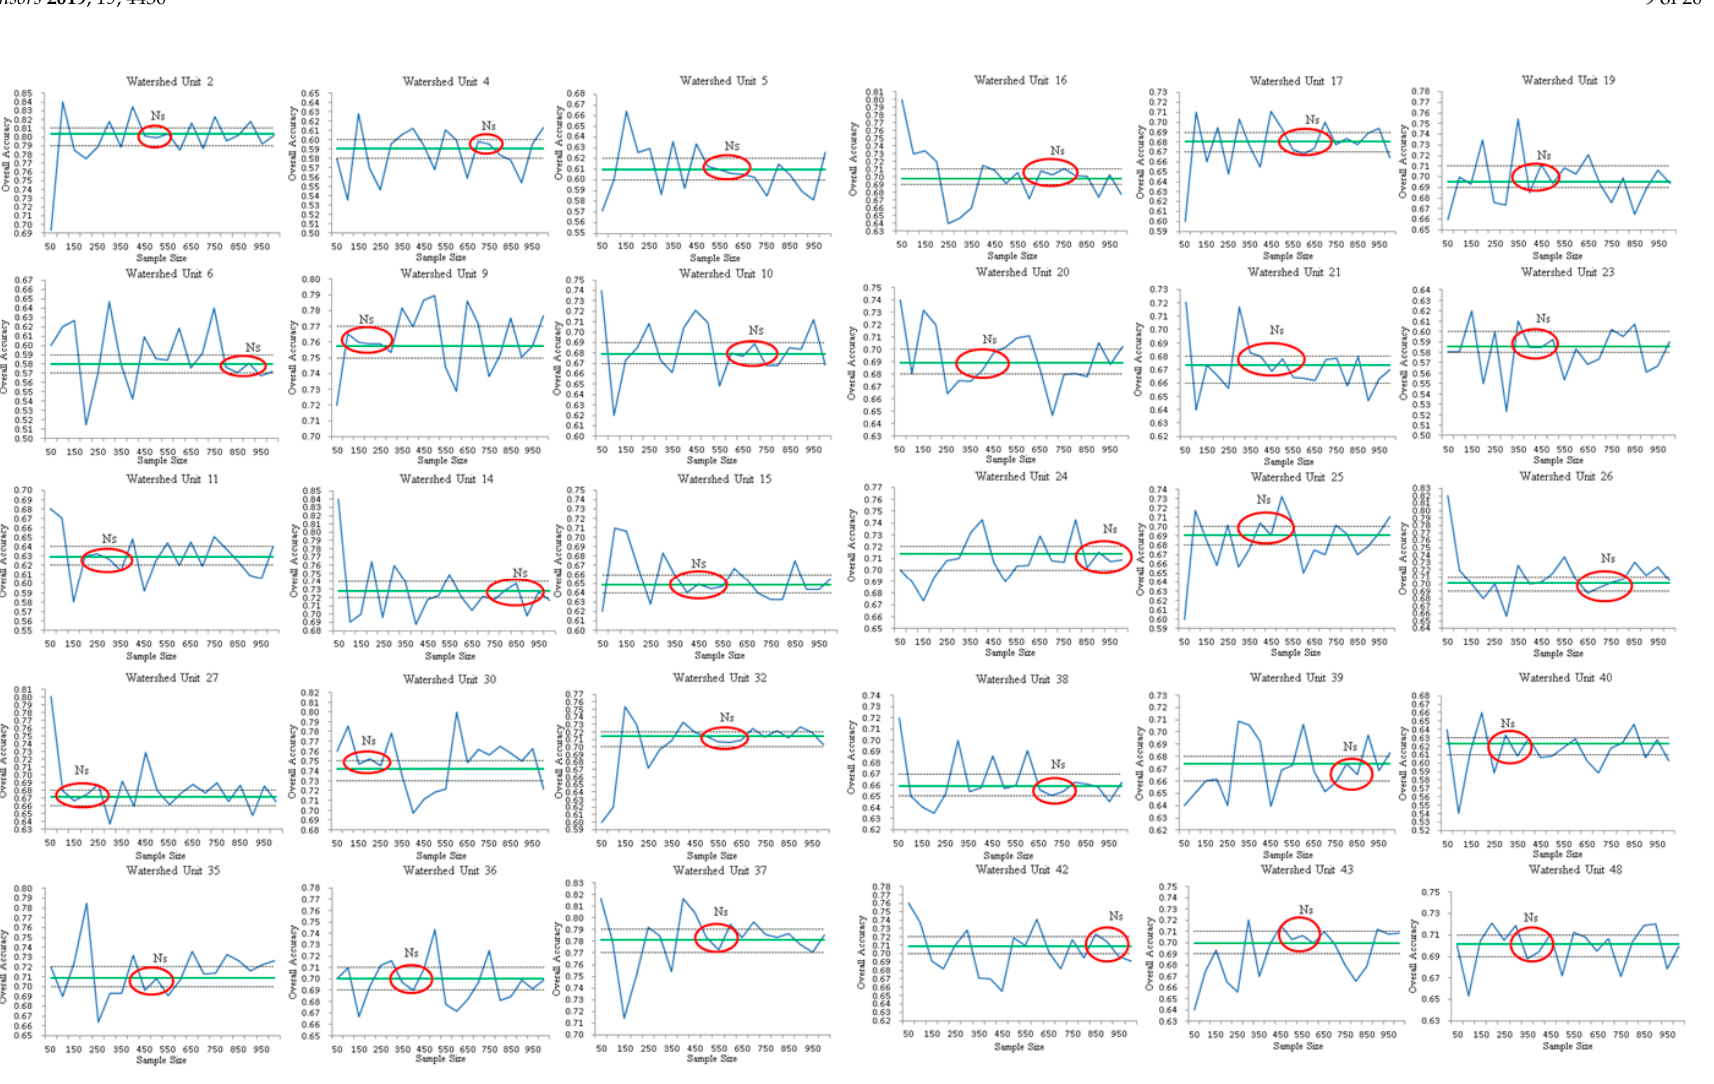
Figure 6. Determination of sample size Ns .